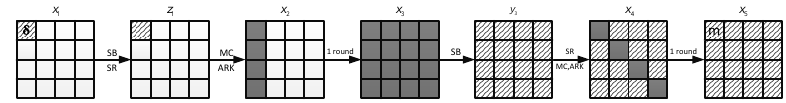
Figure 2: The 4-round AES distinguisher used in [DTÇB09]. The gray cells represent 24 byte- parameters, δ represents the δ -set and m represents the differential sequence to be